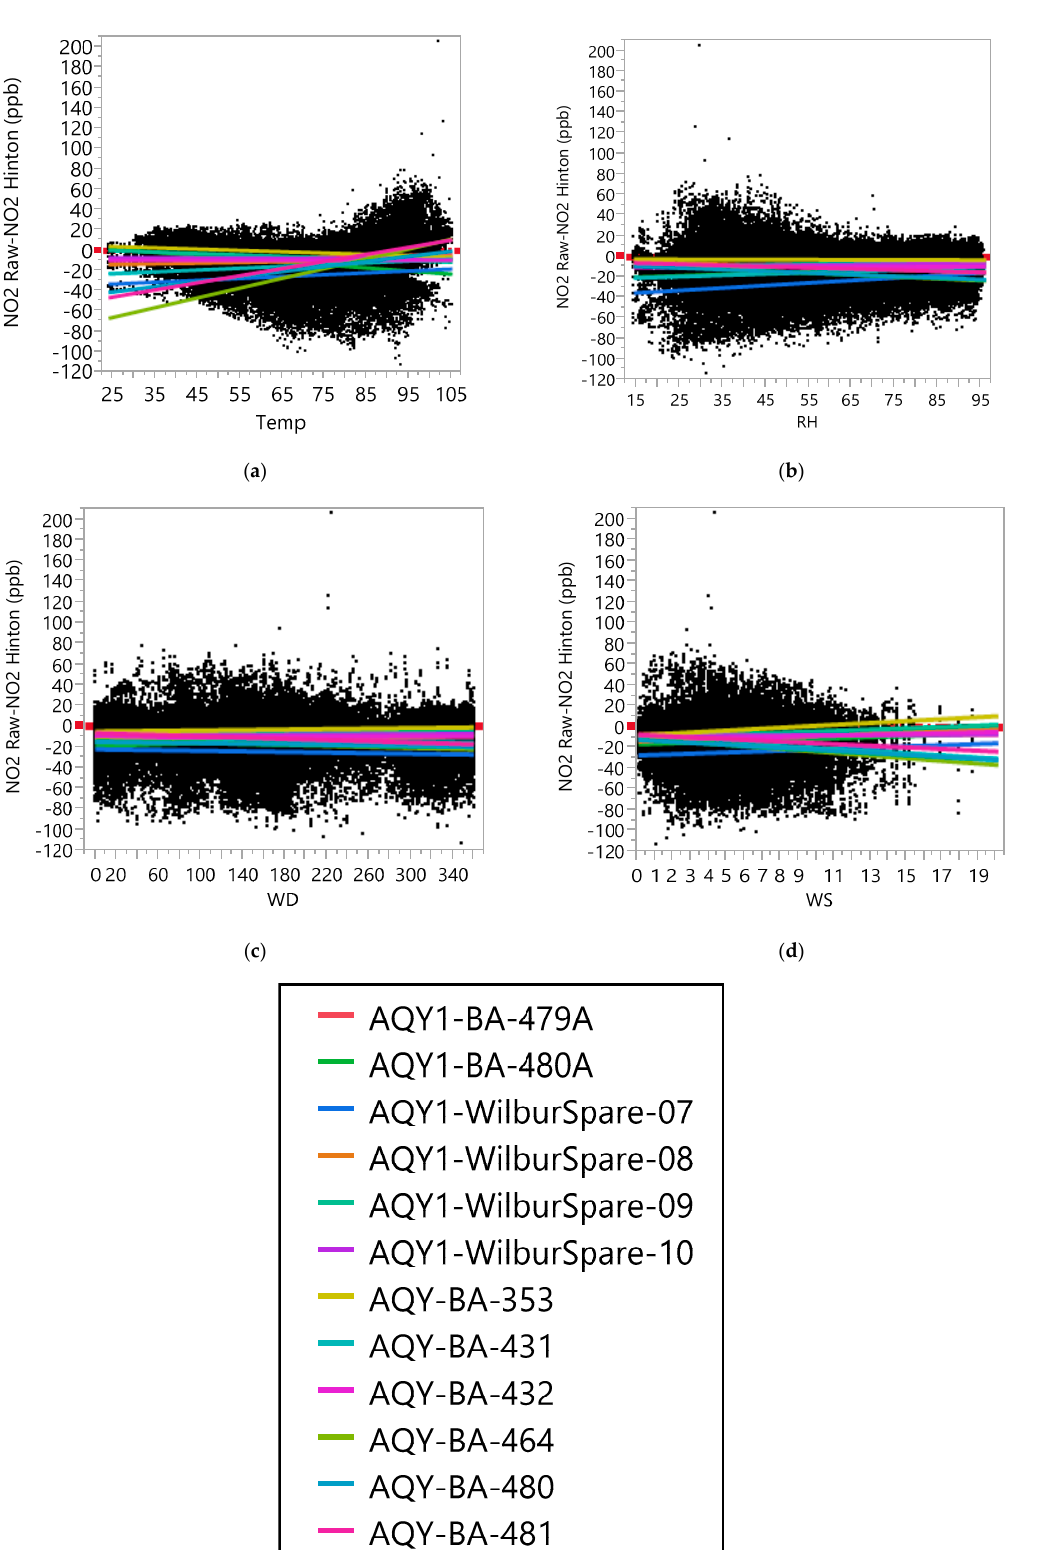
Figure 3. Regression Plot between NO 2 Raw - NO 2 Hinton Data versus ( a ) Temperature ( b ) RH, ( c ) Wind Direction, and ( d ) Wind Speed, as measured at the Hinton Reference Site.